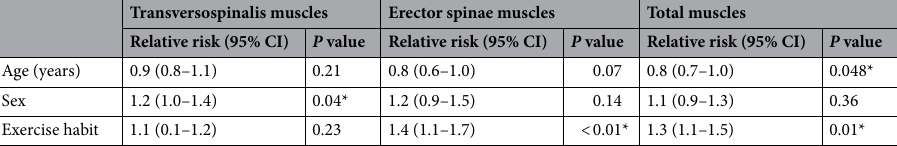
Table 3. Multi-variable adjusted association between changes in CSA over ten years and factors in the Poisson regression model. An asterisk indicates statistical significance. 95% CI, 95% confidence interval.